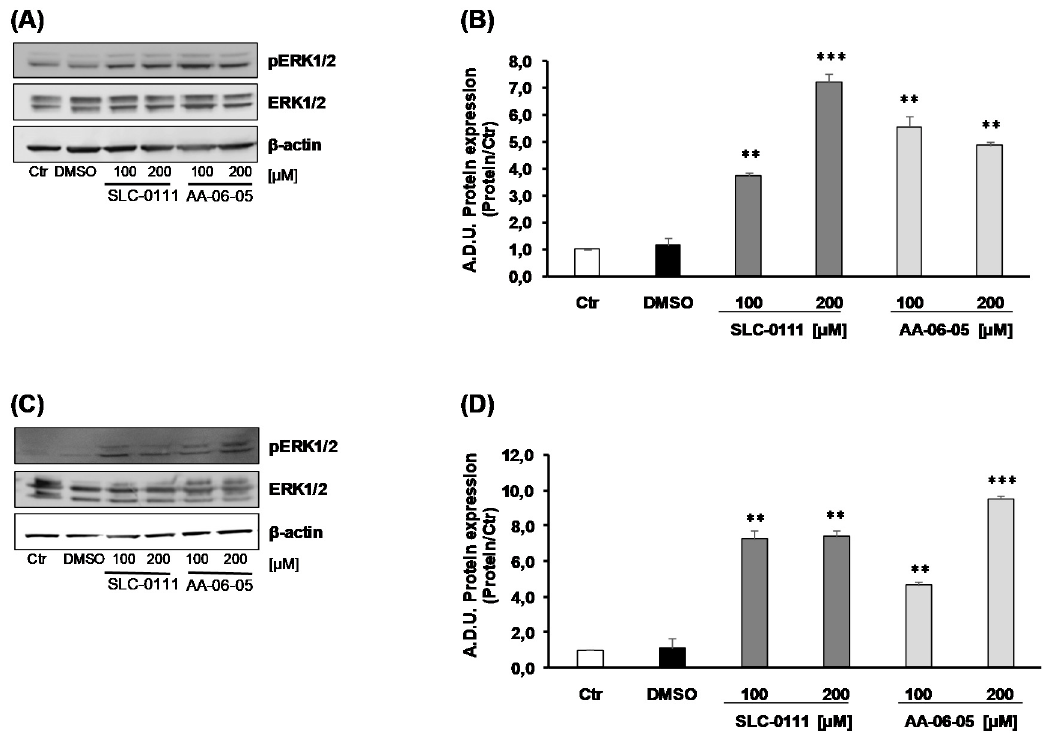
Figure 3. CA-IX pharmacological inhibitors increase the expression and activation of p-ERK1 / 2. MDA-MB-231 ( A , B ) and A549 ( C , D ) were treated with SLC-0111 and AA-06-05 [100–200 µ M] for 30 min. The treatments were performed under experimental condition of medium with 1% FBS. Signals were evaluated through western blot and β -actin was used to normalize protein loading. For each experimental condition Arbitrary Densitometry Units (A.D.U.) ± SD were reported as pERK1 / 2 / total ERK1 / 2 vs basal control. ( n = 3). ** p < 0.01 and *** p < 0.001 vs. untreated cells (Ctr).